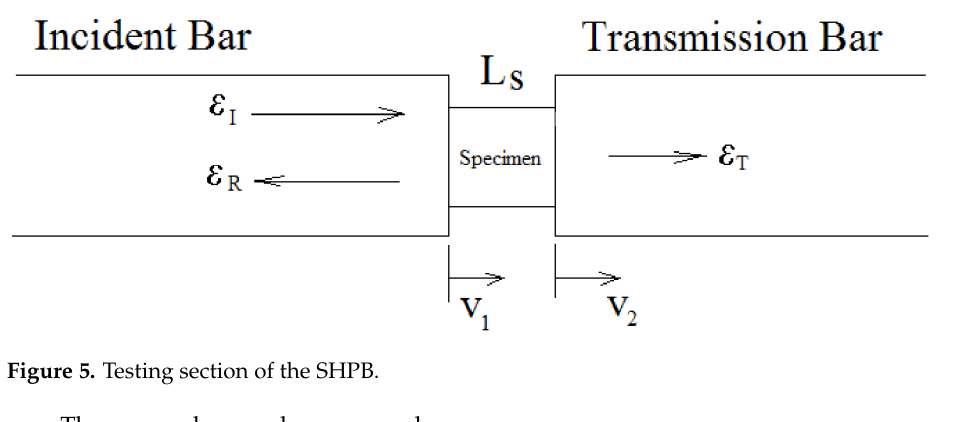
Figure 5. Testing section of the SHPB.